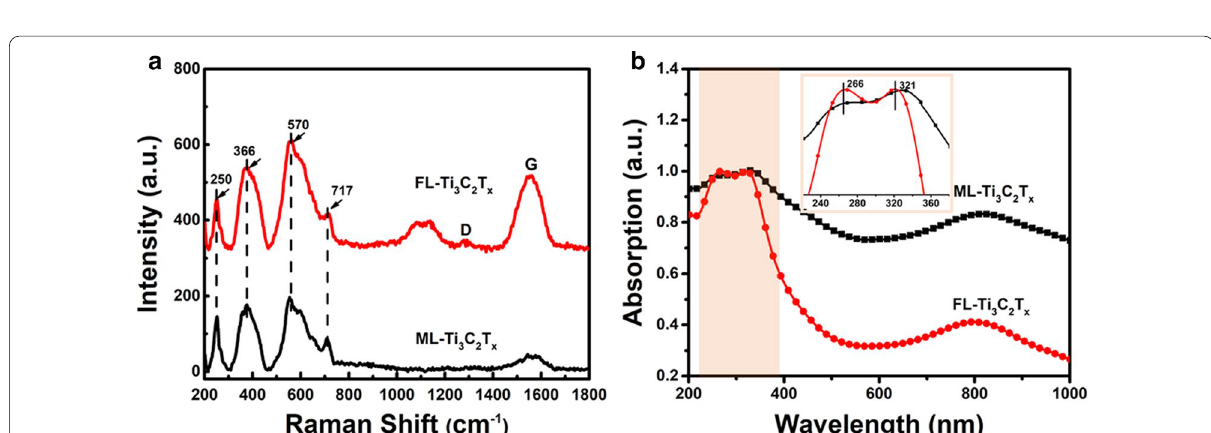
Fig. 2 a Raman spectra and b Normalized absorption spectra of FL‑Ti 3 C 2 T x and ML‑Ti 3 C 2 T x . The inset in b presents the absorption bands of FL‑Ti 3 C 2 T x and ML‑Ti 3 C 2 T x in the UV